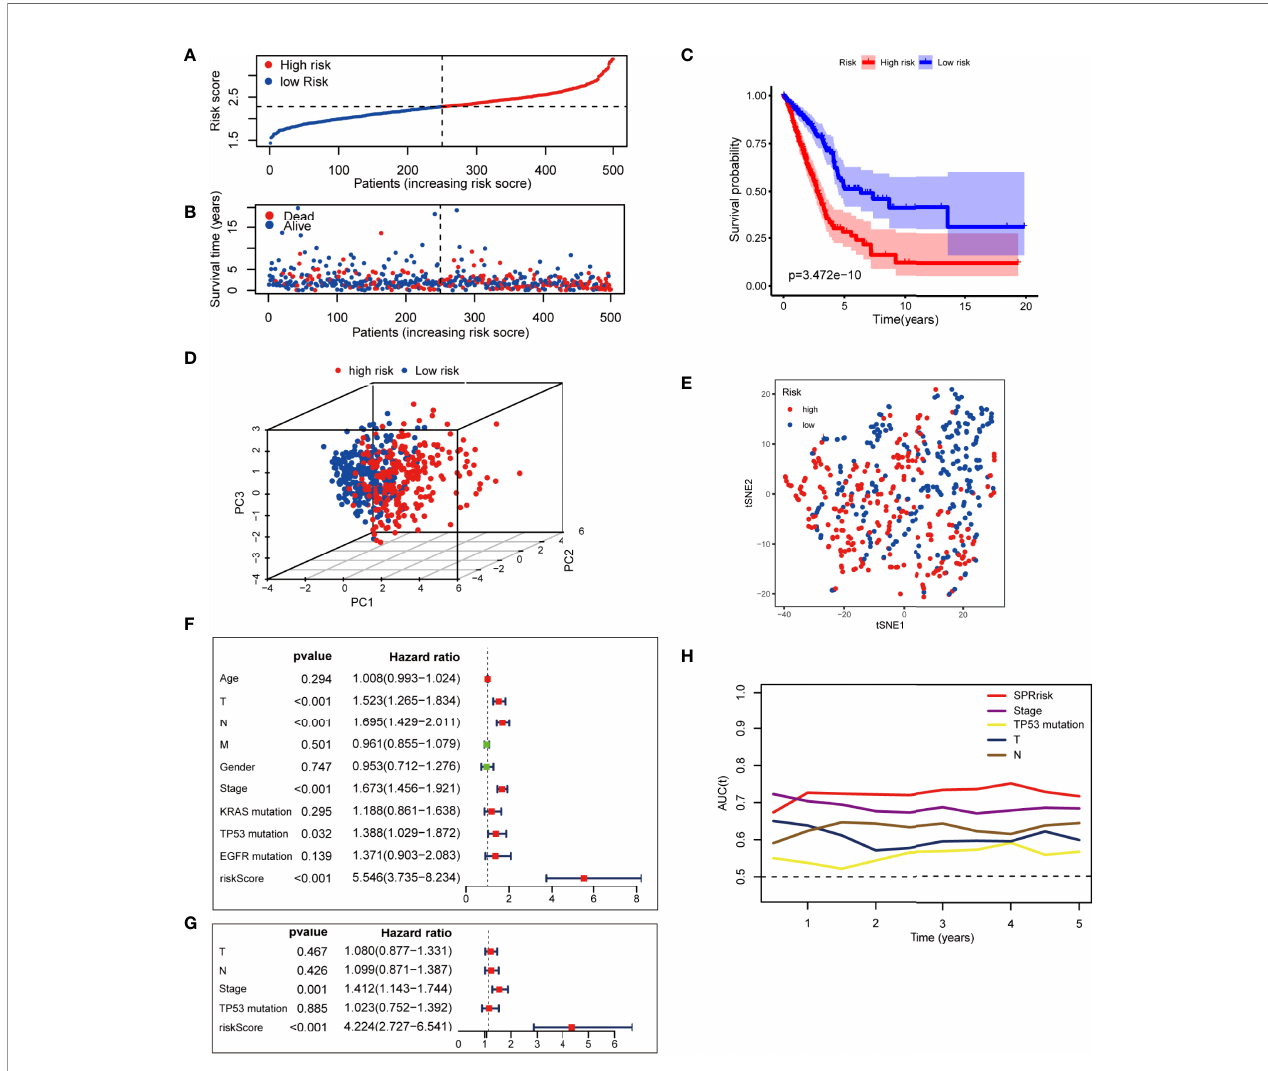
FIGURE 3 | Assessment of the prognostic signature in The Cancer Genome Atlas (TCGA) testing cohort. (A) Distribution of risk score and survival time of patients with lung adenocarcinoma (LUAD). (B) Scatter plot of survival status and risk score in patients with LUAD. (C) Kaplan – Meier curves of overall survival time between high- and low-risk groups using the log-rank test in TCGA LUAD dataset. (D) Principal component analysis of the 9 SPRG expression pro fi les of the high- and low- risk groups. (E) t-SNE analysis of the 9 SPRG expression pro fi les of the high- and low-risk groups as indicated by different colors. (F, G) Forest plot with hazard ratios from the univariate and multivariable Cox proportional hazards regression analysis in TCGA cohort. (H) The areas under the curve of time-dependent receiver operating characteristic curves veri fi ed the prognostic performance of the risk score in TCGA